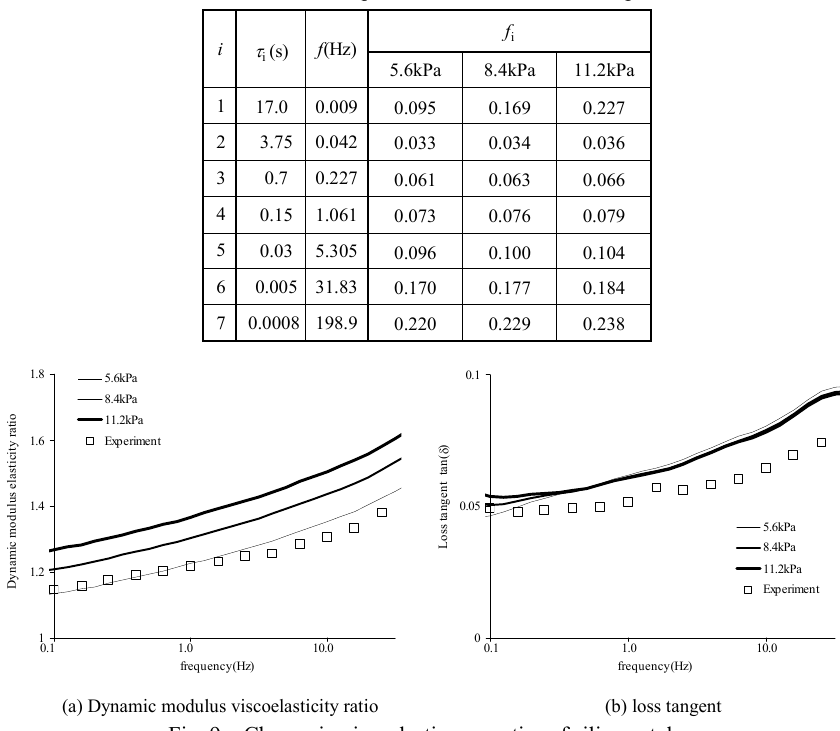
Table 1 Viscoelastic parameters for each baseline